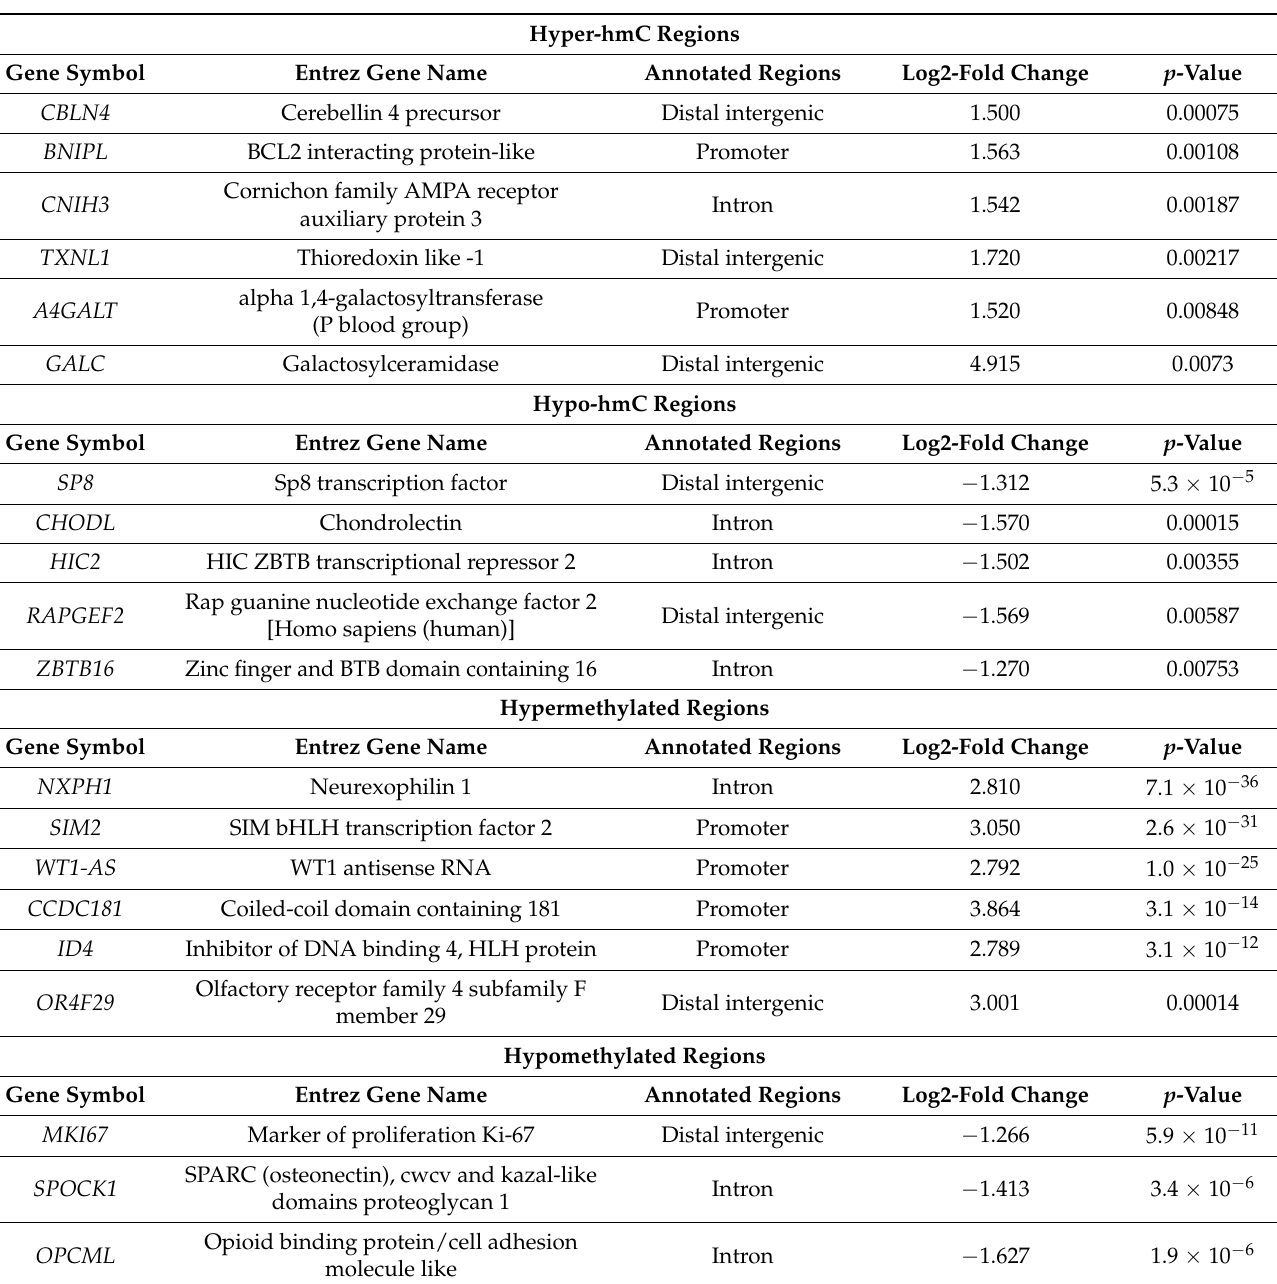
Table 1. Loci-specific candidates of 5-mC and 5-hmC in breast cancer. Hyper-hmC